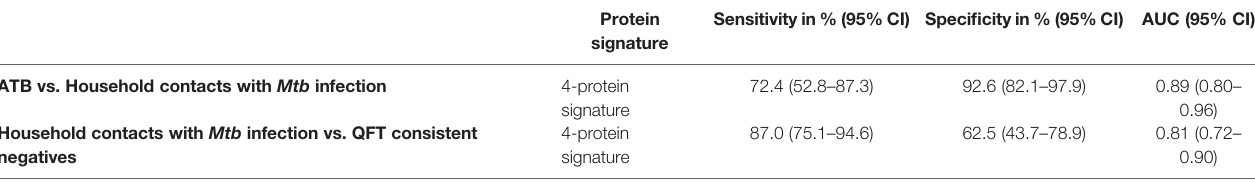
TABLE 3B | Identi fi cation and performance of protein signature.